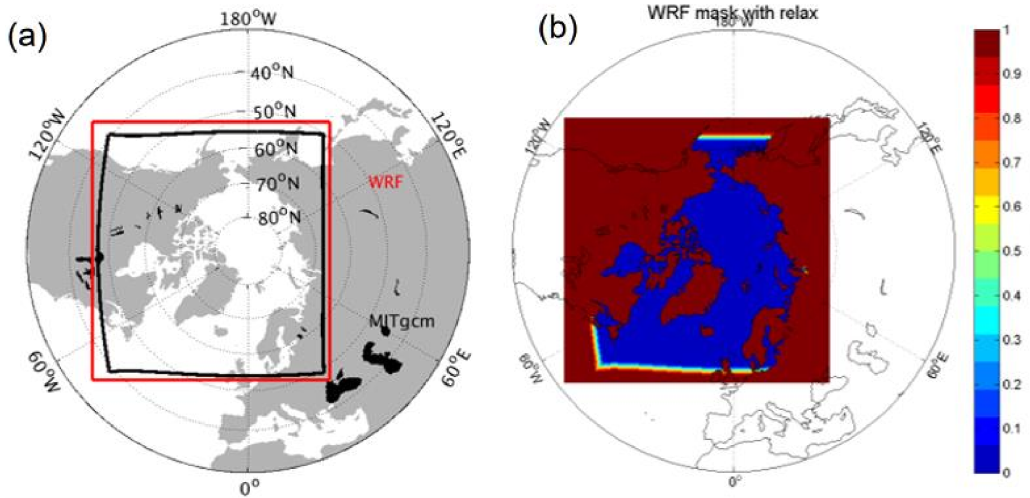
Figure 3. (a) Model domain of the MITgcm and the Polar WRF model. The red and black lines denote the boundaries of the Polar WRF and the MITgcm model, respectively. (b) Relaxation coefficient for the external forcing file of the Polar WRF bottom boundary